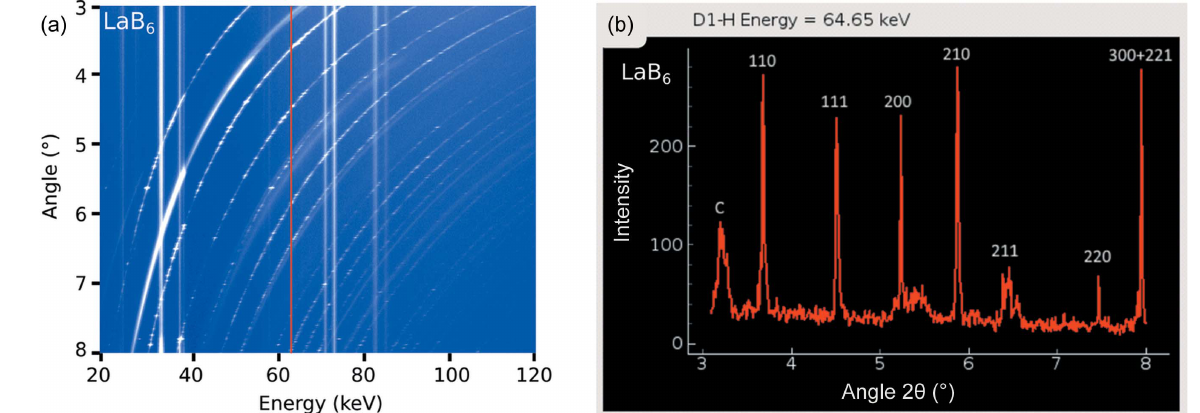
Figure 8 CAESAR data acquisition using the detector system at P61B on LaB 6 powder inside a graphite cylinder at room pressure and temperature. ( a ) Compiled data from all scans (0.01 (cid:5) increment). ( b ) AD-XRD pattern at 64.65 keV showing seven reflections of LaB 6 in the range 3 (cid:5) to 8 (cid:5)